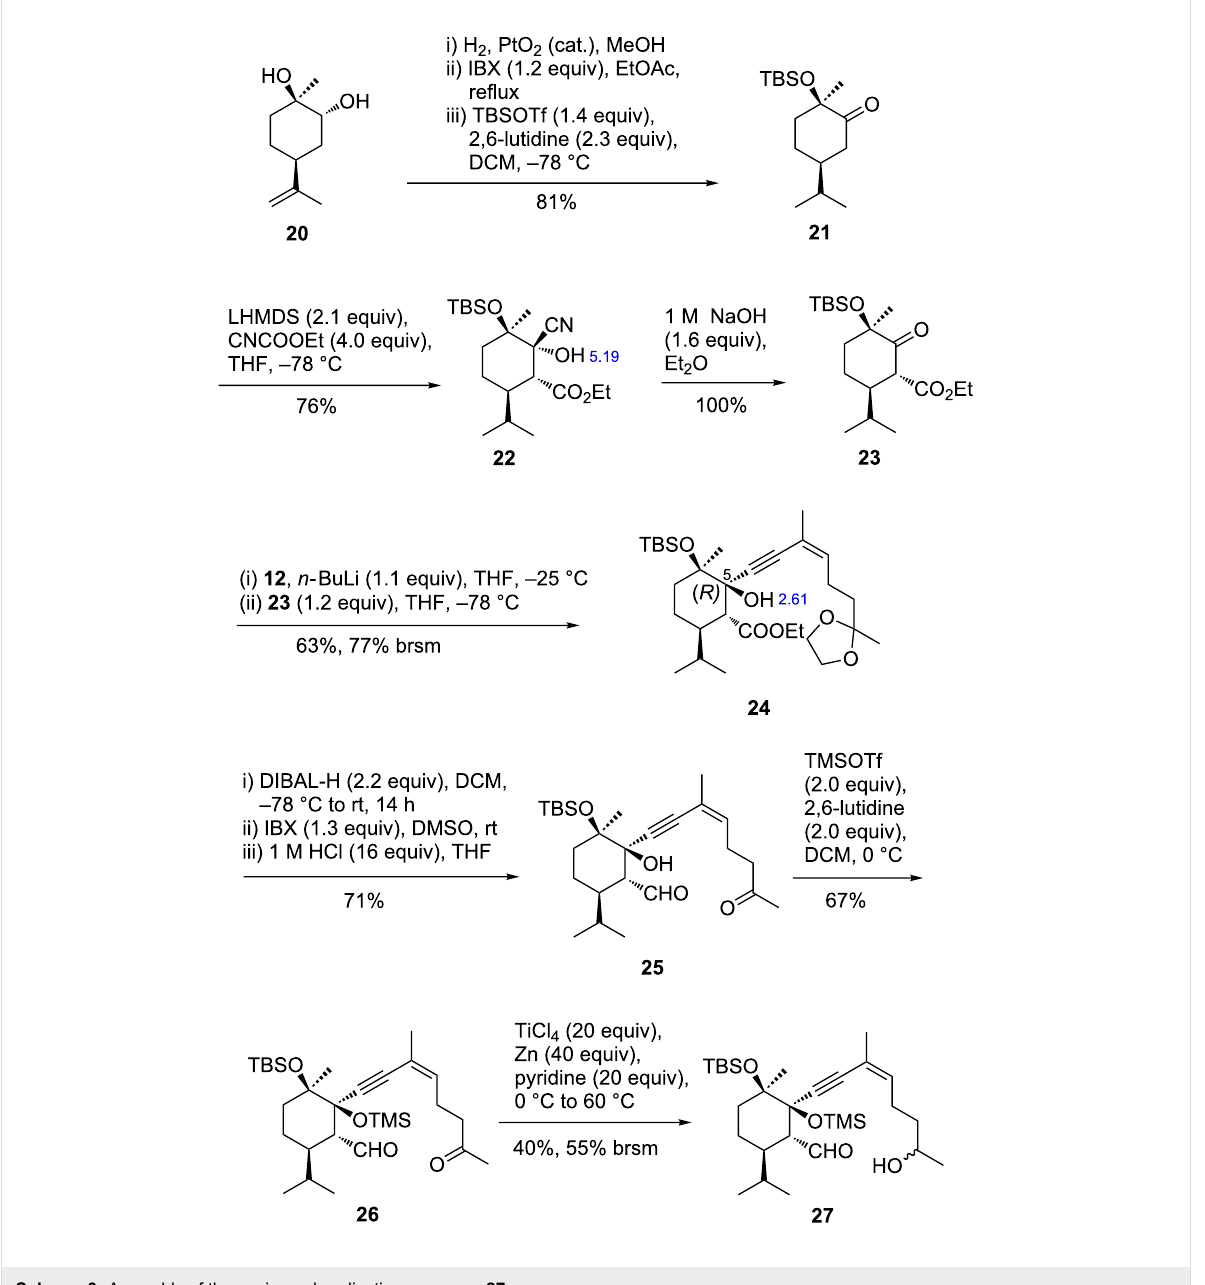
Scheme 3: Assembly of the envisaged cyclization precursor 27